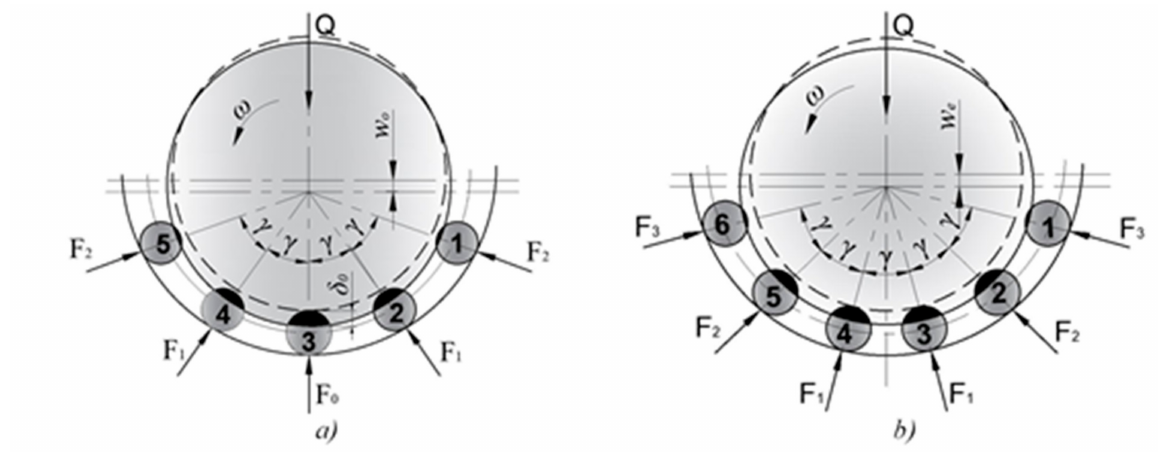
Figure 4. The influence of the external load and contact deformations on the relative displacement between the bearing rings, ( a ) BSO position of support, ( b ) BSE position of